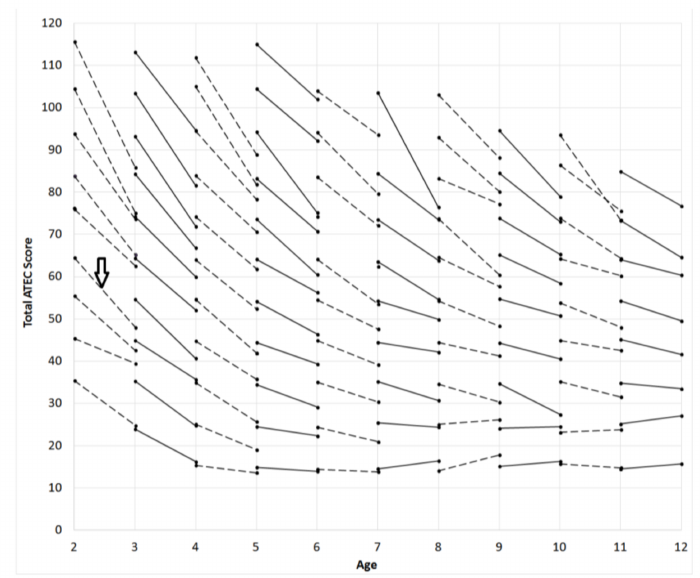
Figure 1. Pair-wise changes in the total Autism Treatment Evaluation Checklist (ATEC) score from one whole-year age to another. Each point represents an average of all participants who completed their first evaluation at one whole-year age and their second evaluation at a following whole-year age. For example, in the 2 to 3 age-pair calculation norms (vertical arrow), a participant must have completed their first evaluation anytime between the ages 1.5 to 2.5 years and a second evaluation between the ages 2.5 and 3.5